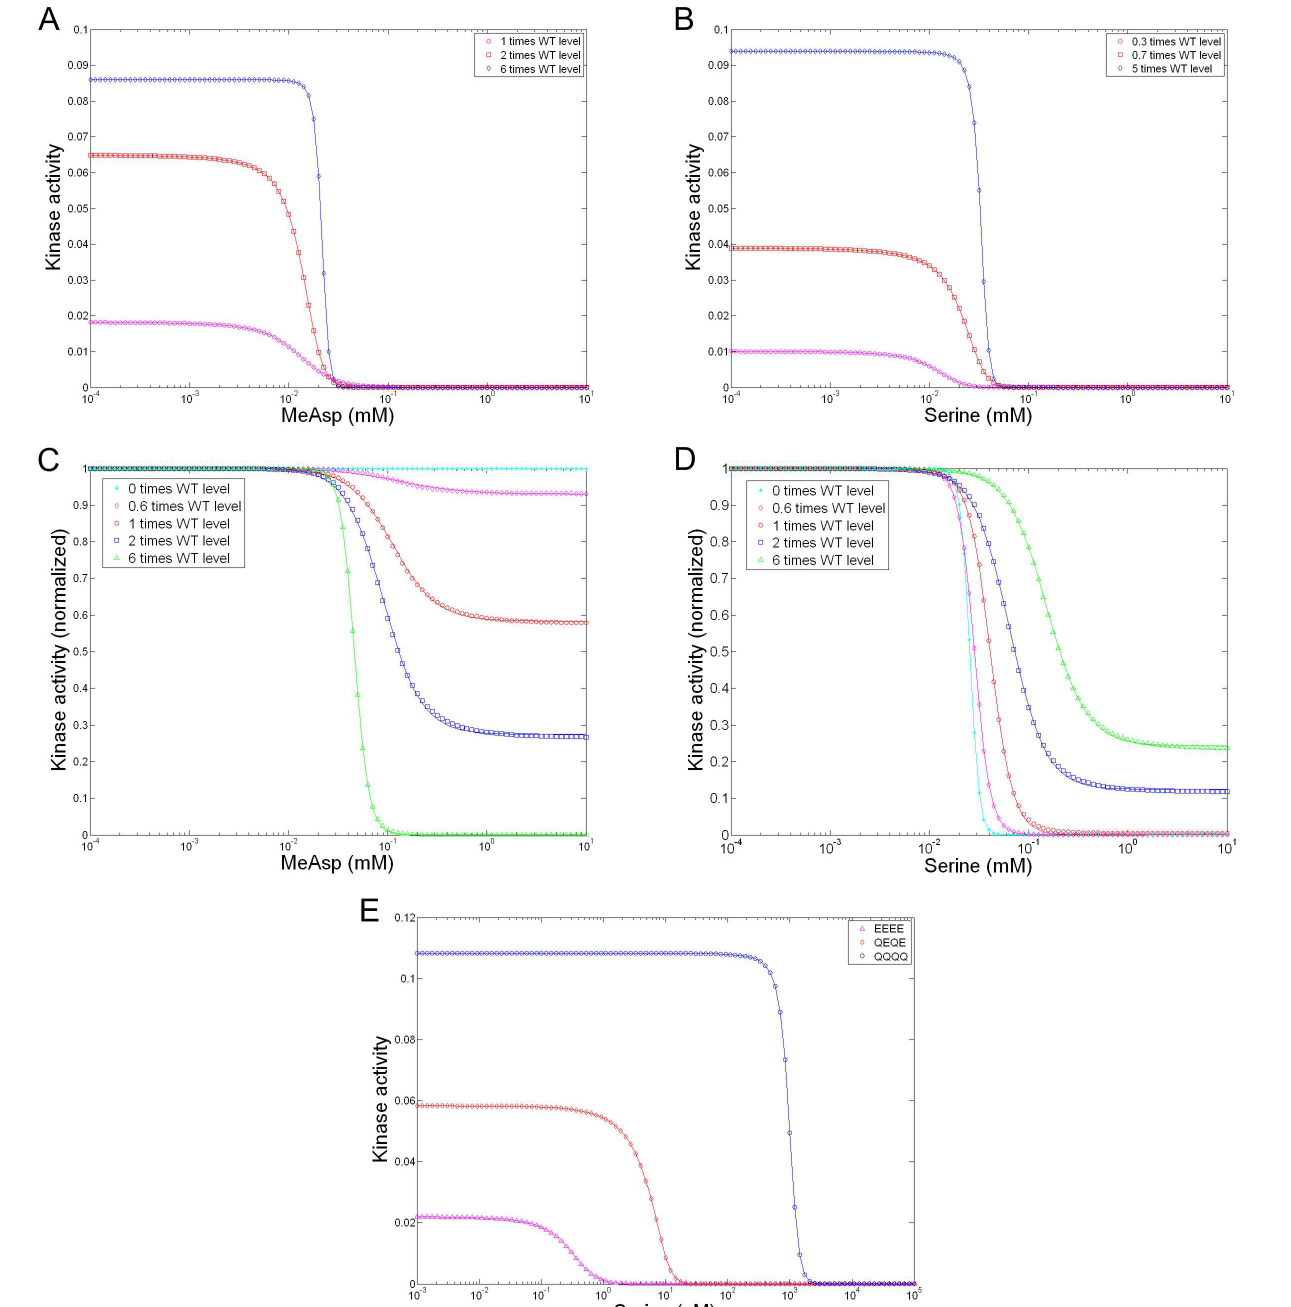
Figure 7. Responses of receptor Tsr in vitro and cheRcheB mutants with varied expression levels of Tar or Tsr. ( A ) Simulated responses to MeAsp of cheRcheB mutant cells expressing only Tar at 1 ( (cid:13) ), 2 ( (cid:3) ) and 6 ( ♦ ) times the native level; ( B ) Simulated responses to serine of cheRcheB mutant cells expressing only Tsr at 0.3 ( (cid:13) ), 0.7 ( (cid:3) ) and 5 ( ♦ ) times the native level; ( C ) Simulated responses to MeAsp of cheRcheB mutant cells expressing Tsr at the native level and Tar at 0 ( ∗ ), 0.6 ( ♦ ), 1 ( (cid:13) ), 2 ( (cid:3) ) and 6 ( △ ) times the native level; ( D ) Simulated responses to serine of cheRcheB mutant cells expressing Tsr at the native level and Tar at 0 ( ∗ ), 0.6 ( ♦ ), 1 ( (cid:13) ), 2 ( (cid:3) ) and 6 ( △ ) times the native level; ( E ) Simulated responses to serine by the receptor Tsr at the methylation state QQQQ ( (cid:13) ), QEQE ( ♦ ) and EEEE ( △